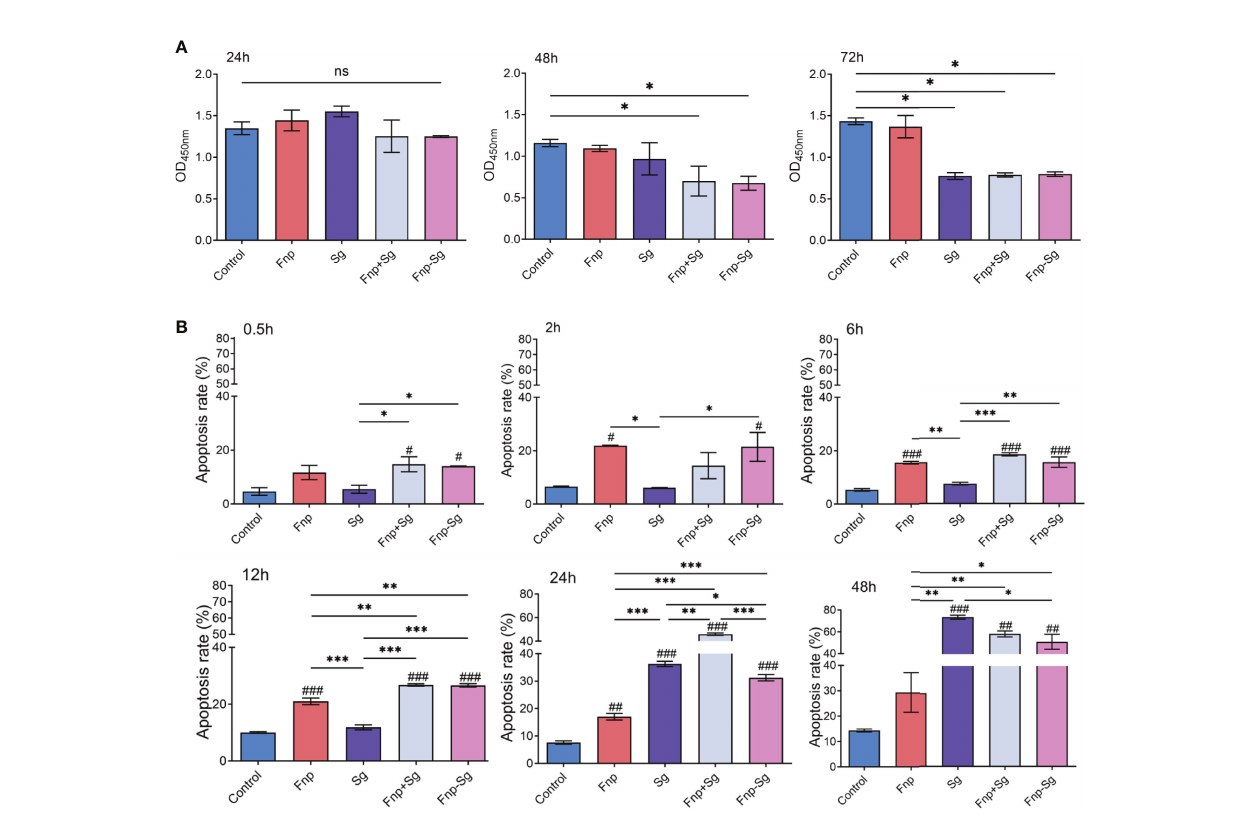
FIGURE 5 | (A) The proliferation activity of hGECs infected by Fnp, Sg, Fnp+Sg and Fnp-Sg after 24, 48 and 72 h of infection (* p <0.05 , ns: not statistically signi fi cant). (B) The apoptosis rate of hGECs infected with Fnp, Sg, Fnp+Sg and Fnp-Sg after various time points (* p < 0.05, **p < 0.01, ***p < 0.001; # p < 0.05,